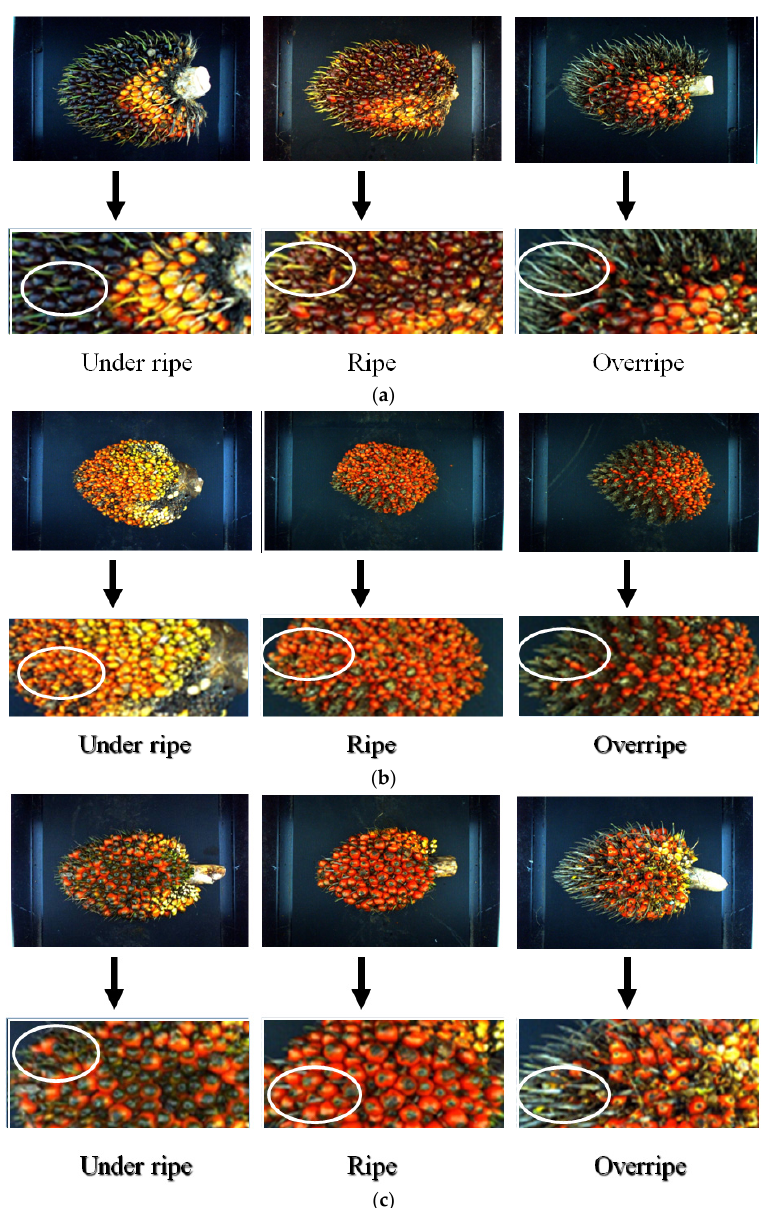
Figure 2. FFB ripening classes of oil palm: ( a ) Nigarsens, ( b ) Olifera, ( c ) Varseness.